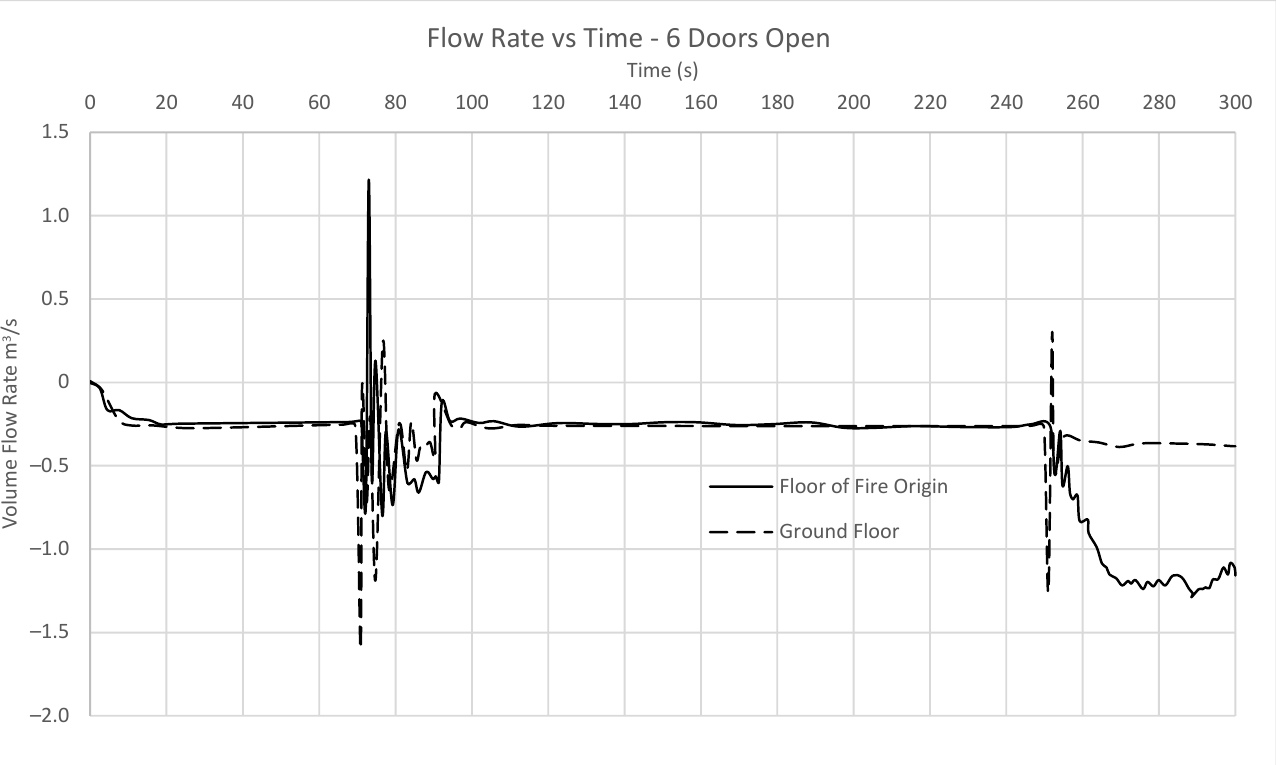
Figure 8. Volume flow rates through the ground floor door and floor of fire origin with six doors open into the shaft.